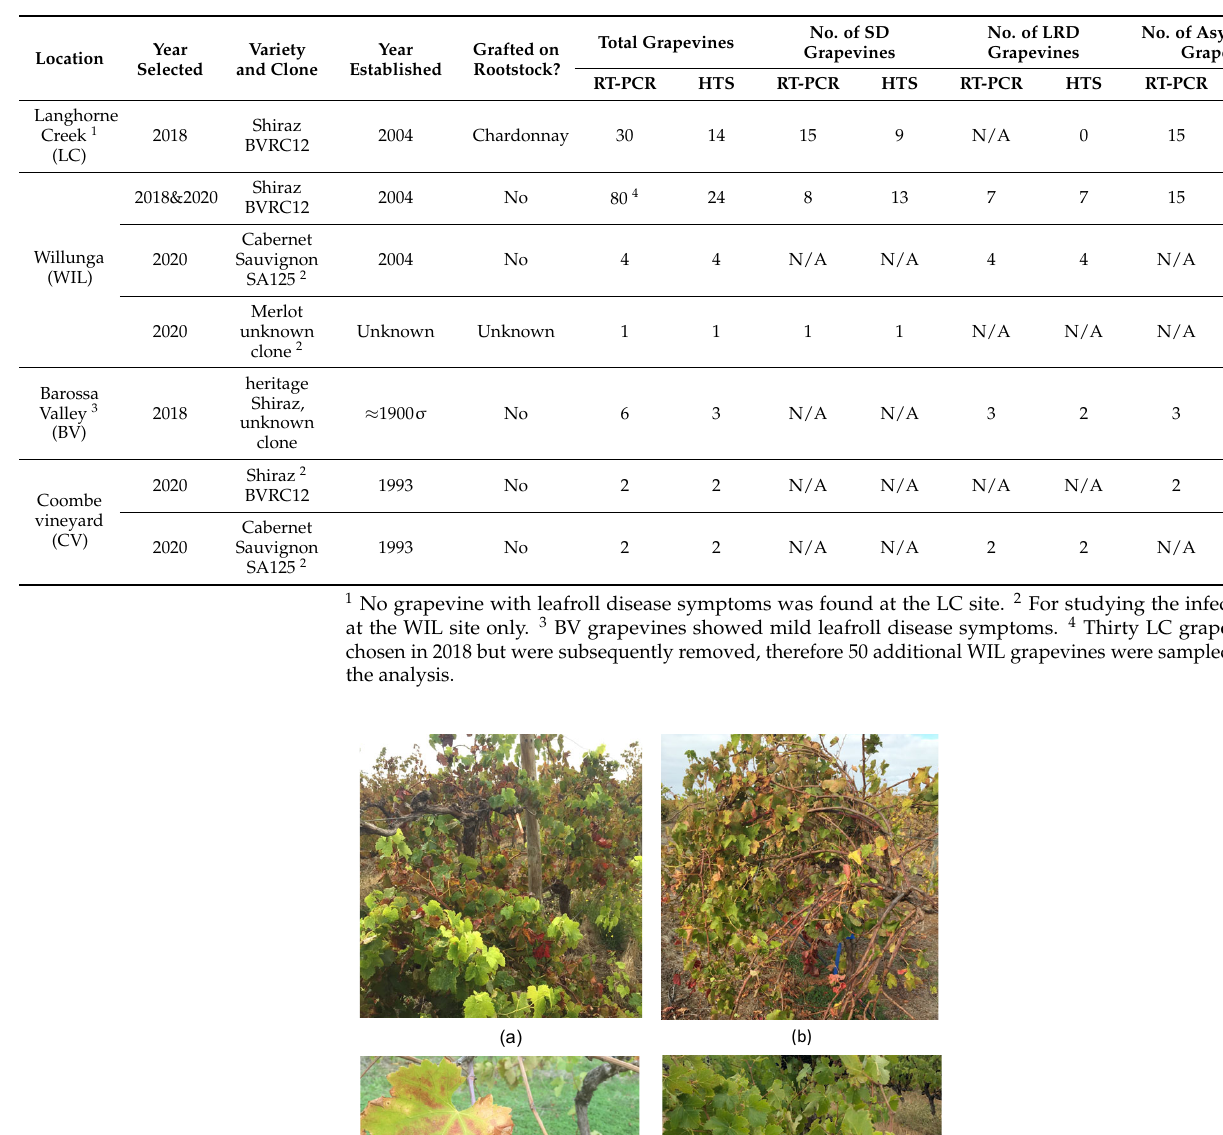
Table 1. The number of grapevines, their location, variety/clone, year planted and symptoms selected for the reverse transcription polymerase chain reaction (RT-PCR) and metagenomics high-throughput sequencing (Meta-HTS) experiments.